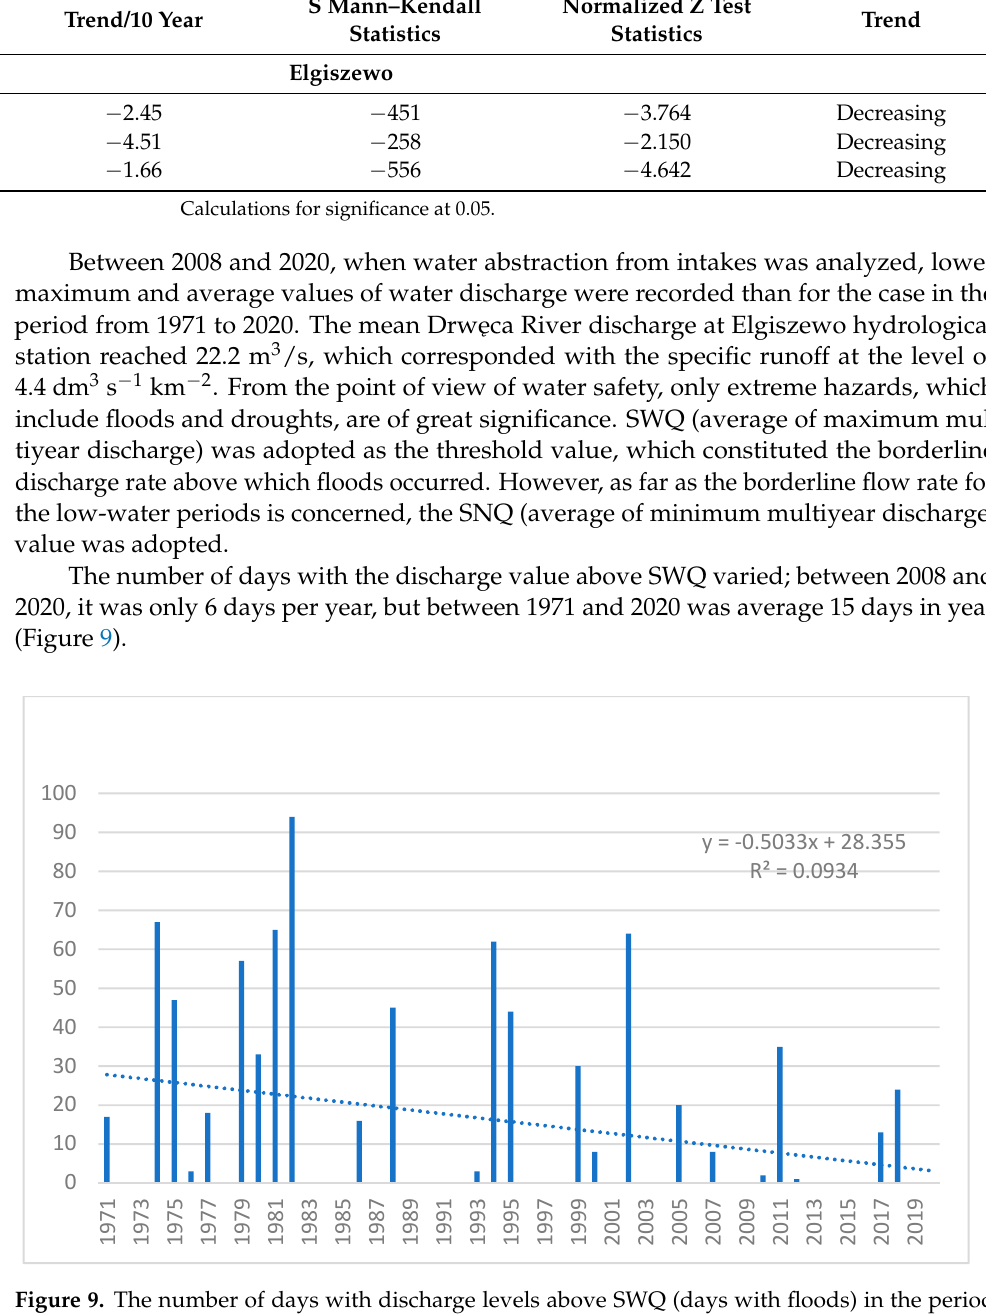
Figure 10. The number of days per year with water discharge levels below SNQ. The total number of days with floods and hydrological droughts in extreme situa- tions constituted 57.8% of all days in the year (2014), whereas the average number of days per year between 2008 and 2020 was 26.4% of all the days per year (Figure 11).